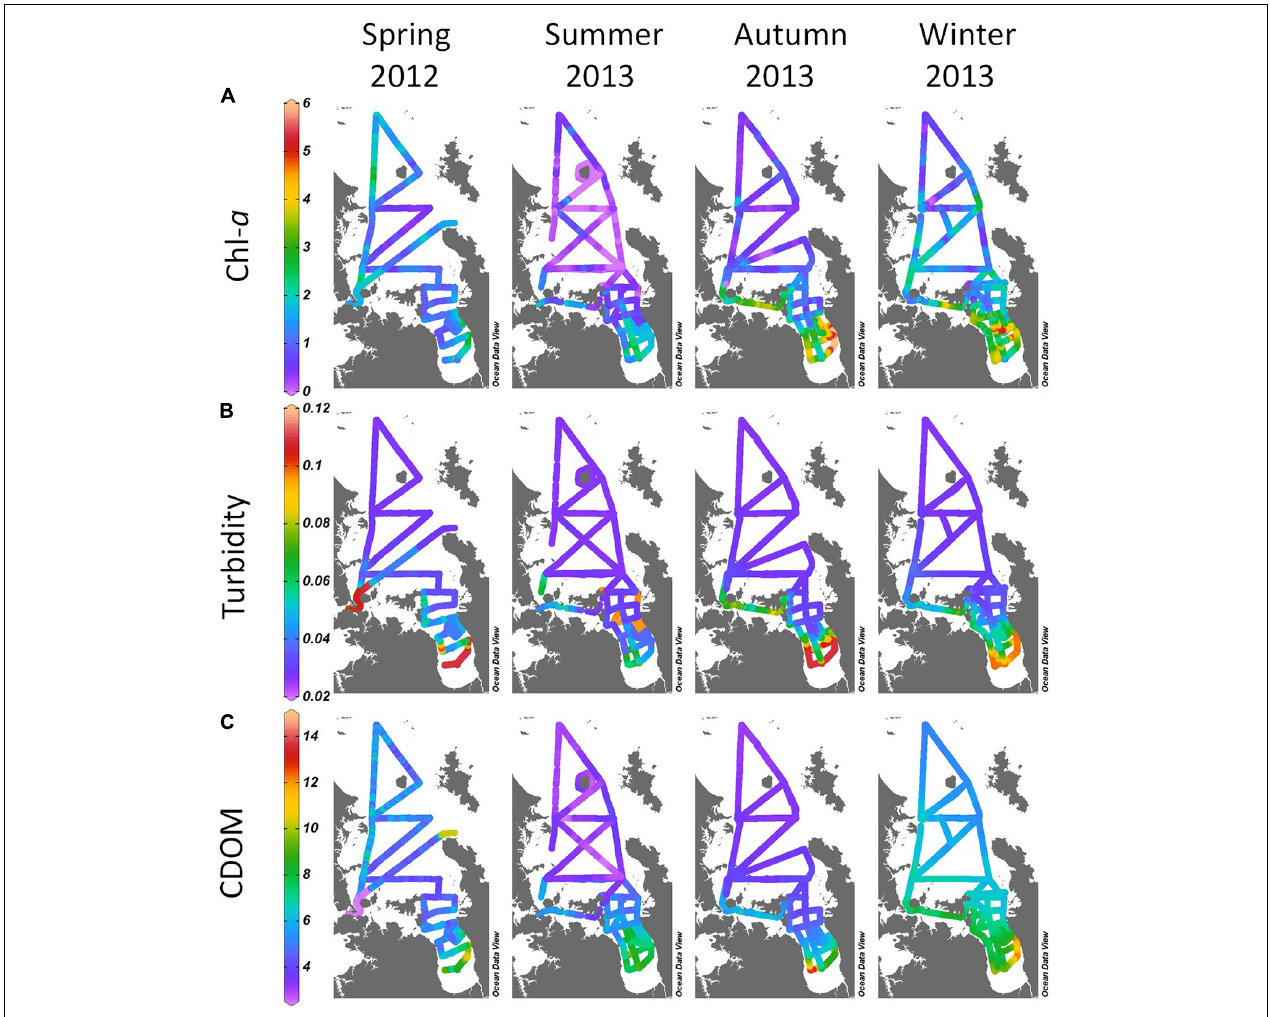
FIGURE 5 | Ribbon plots of near-surface (A) chlorophyll- a (mg m − 3 ), (B) turbidity [as backscatter (m − 1 steradian − 1 )] and (C) coloured dissolved organic matter (CDOM: ppm) in spring, summer, autumn and winter from underway surveys in 2012-13 across the NE shelf, Hauraki Gulf and